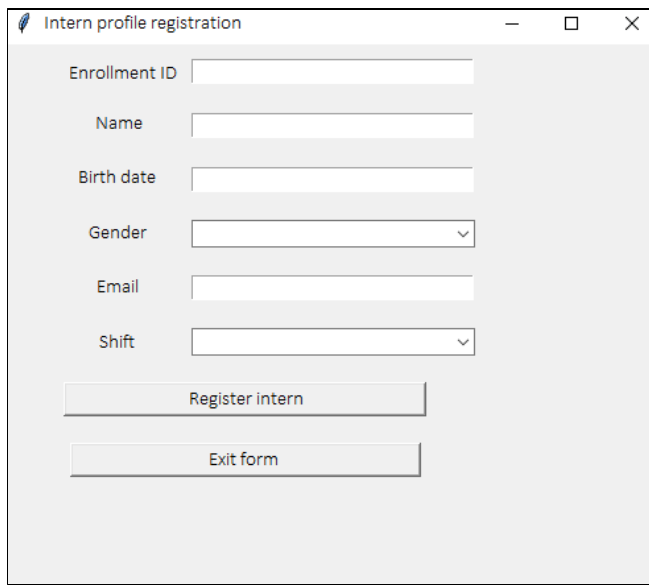
Figure 5: Intern registration form.